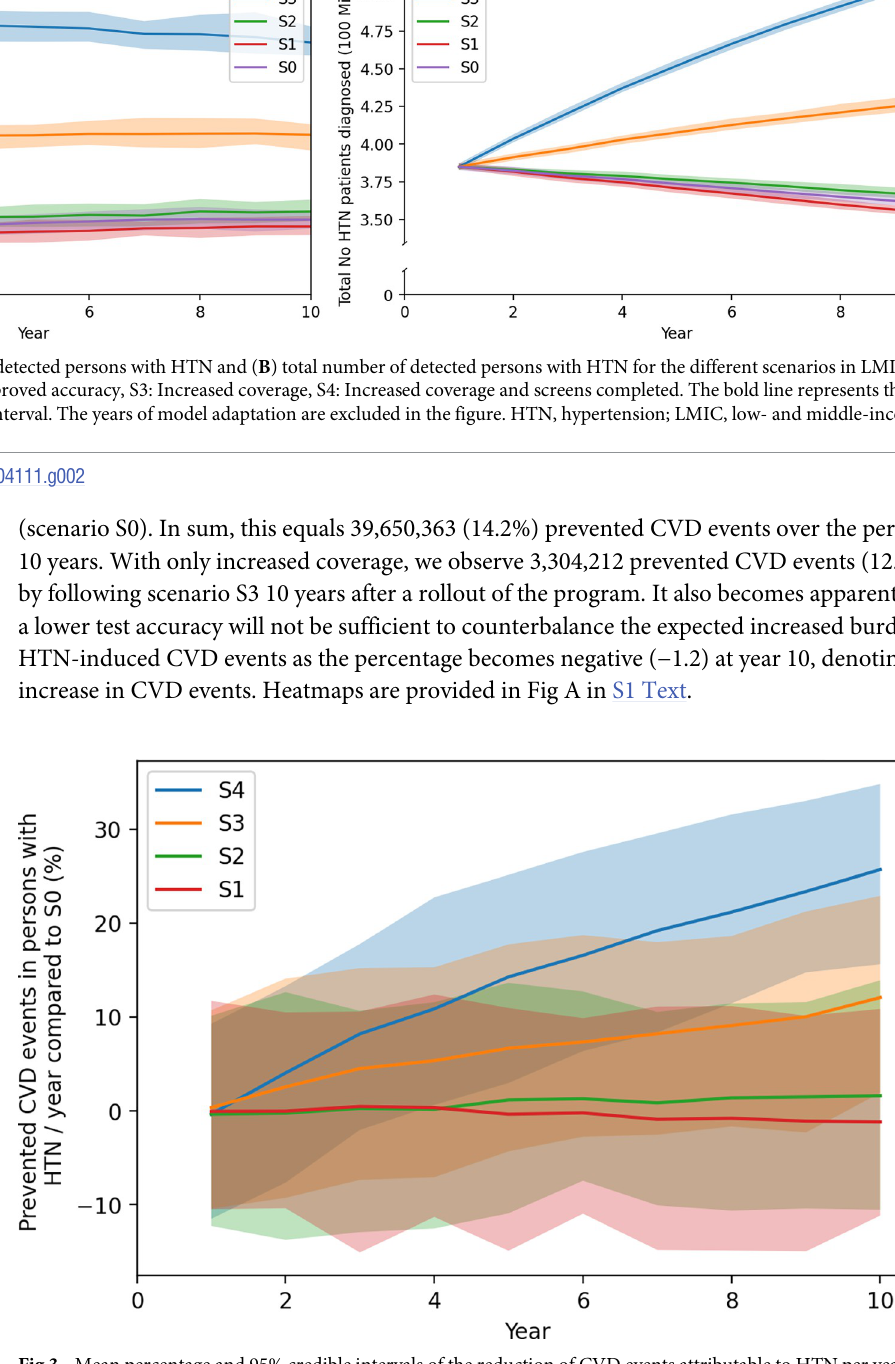
Fig 3. Mean percentage and 95% credible intervals of the reduction of CVD events attributable to HTN per year of the scenarios S1: Lower accuracy, S2: Improved accuracy, S3: Increased coverage, and S4: Increased coverage and screens completed compared to the baseline case S0. The bold line represents the mean value and the band the 95% credible interval. The first years of model adaptation are excluded in the figure. CVD, cardiovascular disease; HTN,